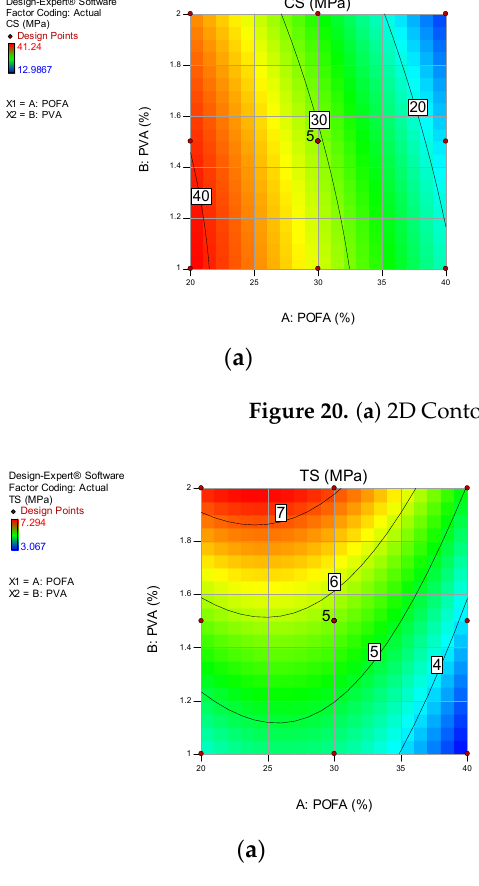
Figure 21. ( a ) 2D Contour Plot and ( b ) 3D Response Surface Diagram for Tensile Strength.